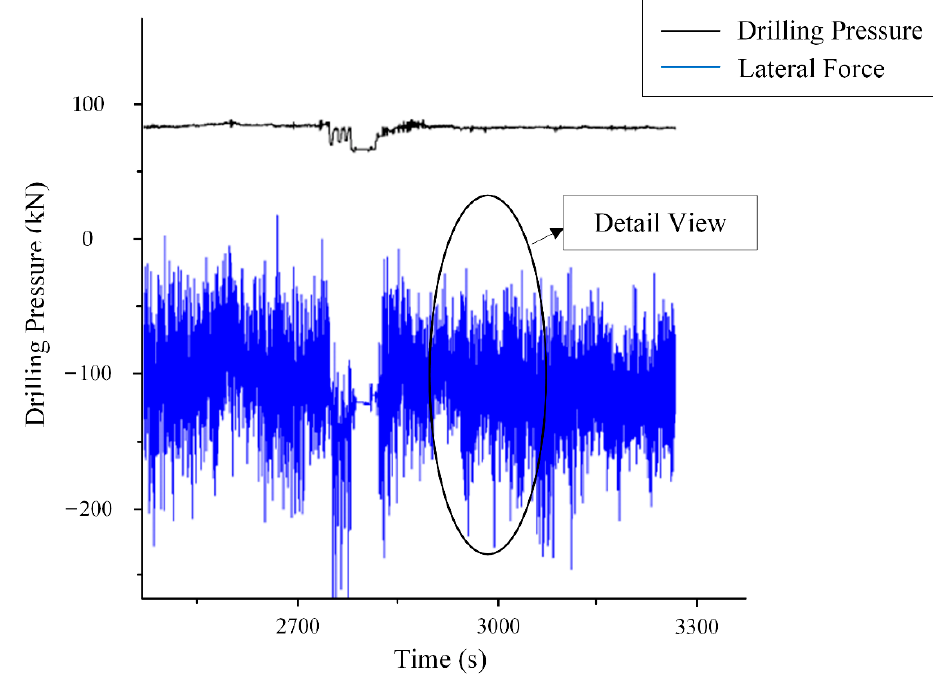
Figure 10. Relationship between the lateral force and drilling pressure.